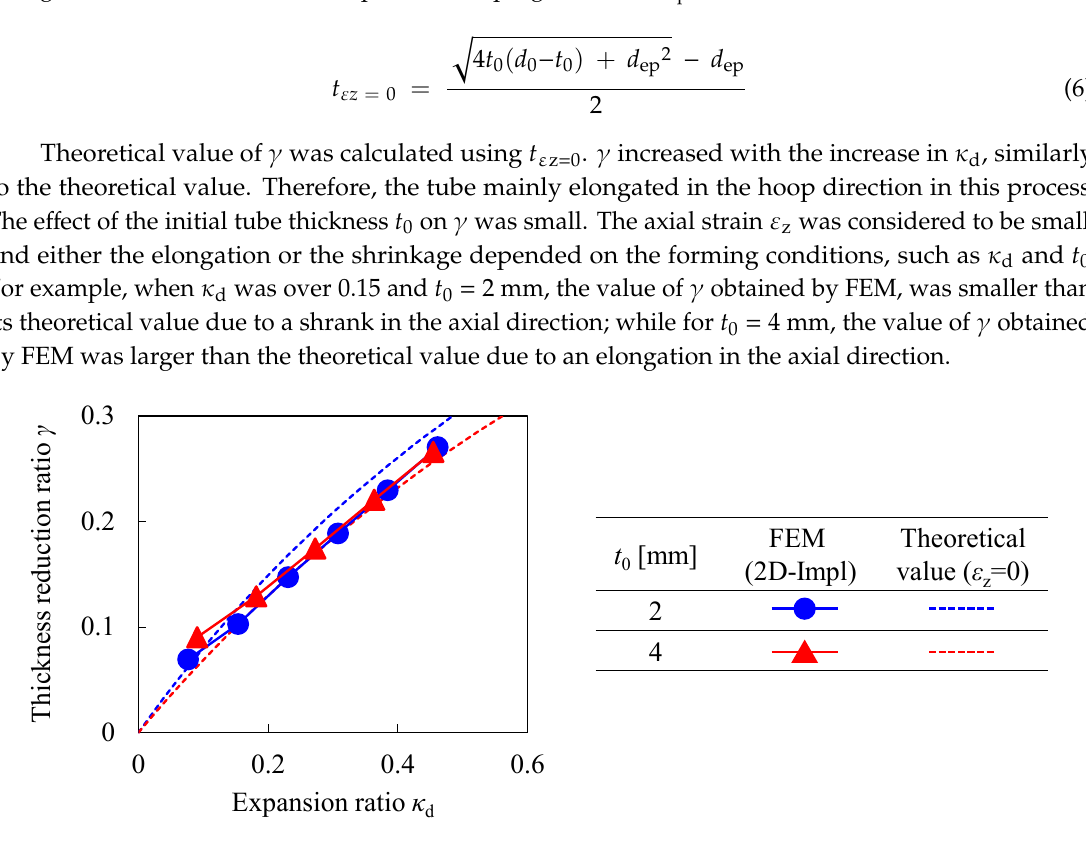
Figure 11. Relationship between thickness reduction ratio γ and drawing load P (STKM13C, 2D FEM).